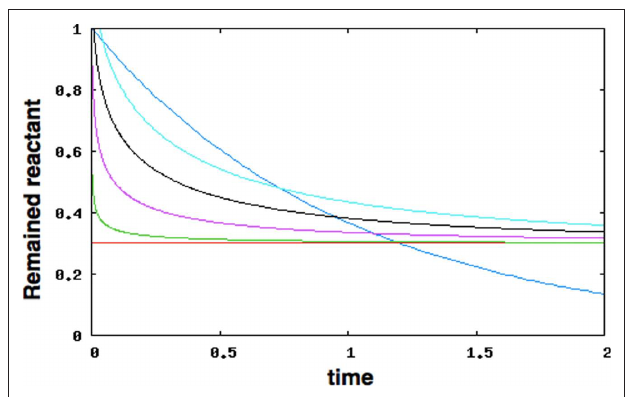
FiguRe A4 | The fluctuation of remained reactant. The blue line is the case of homogeneous environment ( k = − 1, constant in d [reactant]/ dt ). The other lines are the case of df = 1.0, 1.2, 1.4, 1.6, 1.8, respectively (cyan, black, purple, green and red). This graph shows that when df takes a value between 1 ≤ df < 2,